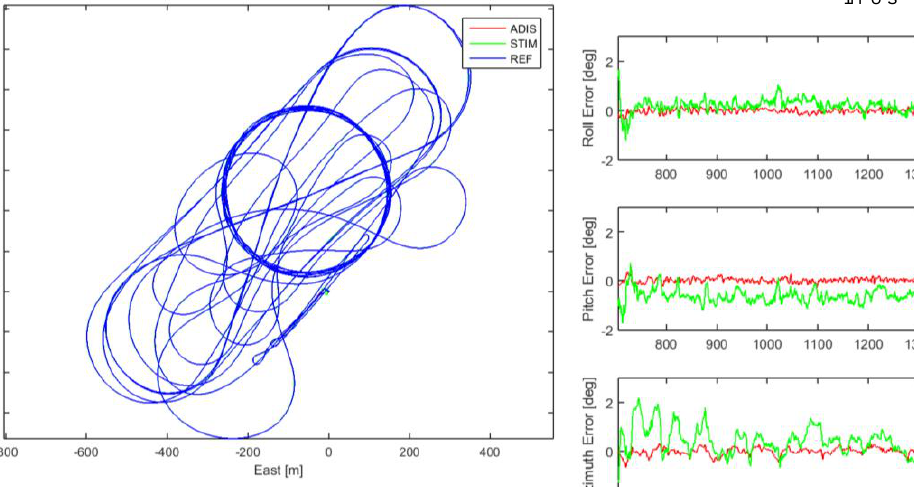
Figure 6. UAV trajectory results by using INS/RTK for both sensors ADIS, STIM and the reference Figure 8. Roll, Pitch, and Azimuth errors for ADIS and STIM Figure 7 and Figure 8 demonstrate position and attitude error sensors between the reference and INS/RTK integration for both ADIS and STIM IMUs with position and velocity update respectively. Figure 9 represents the azimuth convergence time using both The ADIS sensor is represented by the red line, whilst the green ADIS and STIM IMUs, they are approximately the same. Thus, line presents the STIM sensor. The position and attitude (PA) the UAV have to loiter or remain on the tarmac for RMSEs for both sensors ADIS and STIM are explained in approximately 7 min after alignment and before initializing the Table 1. The RMSEs are computed during the flight period mission. The period in between the blue lines presents the flight which is after the take-off and before the landing. period which is after the take-off and before the landing. The red line represents the ADIS IMU heading standard deviation, while the STIM IMU heading standard deviation is represented by the green